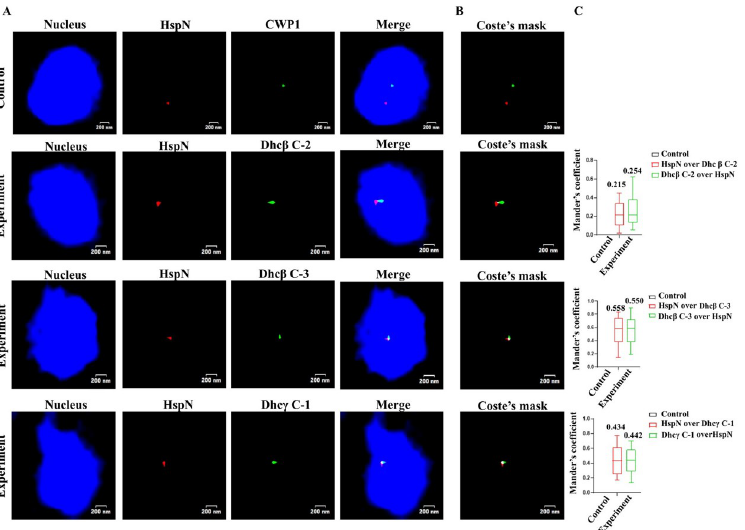
Fig 5. Fluorescence in situ hybridization shows co-localization of HspN and Dynein ORFs within the nucleus. A) Representative two-coloured FISH images showing localization of HspN on chromosome 5 and Dhc β C-2 (chromosome 5), Dhc β C-3 (chromosome 5) and Dhc Ɣ C-1 (chromosome 3). Top panel shows FISH using probes against HspN (red) and CWP1 (green) which serves as a negative control for co-localization. Merged images represent co-localization of HspN (red) and dynein genes (green). Multiple “Z stacks” were captured for every image in control as well as experiments and the resulting images were stacked to give the “merged” image. Genomic DNA was counterstained with DAPI (blue). B) Depicts the Coste’s mask (merge of green and red foci) for representative FISH images. Merged foci (white dot) as shown in experiment depicts true co-localization of the HspN and dynein genes. C) Quantitation of co-localization signal in Giardia nuclei. Box-and-whisker plots depicting Mander’s co-localization coefficient (range 0–1, where 0 signifies no co-localization and 1 signifies100% co-localization) as evaluated by JACoP plug-in of ImageJ software. A minimum of 30 cells were analysed for co-localization of red and green signals in each experiment and plotted as the fraction of red overlapping green (red) and green overlapping red (green). Control refers to co-localization analysis performed with HspN and CWP1